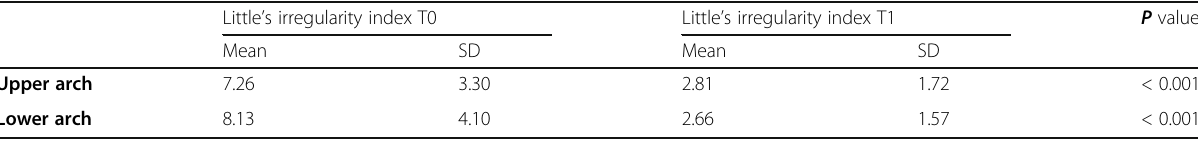
Table 3 Little ’ s irregularity index before and after